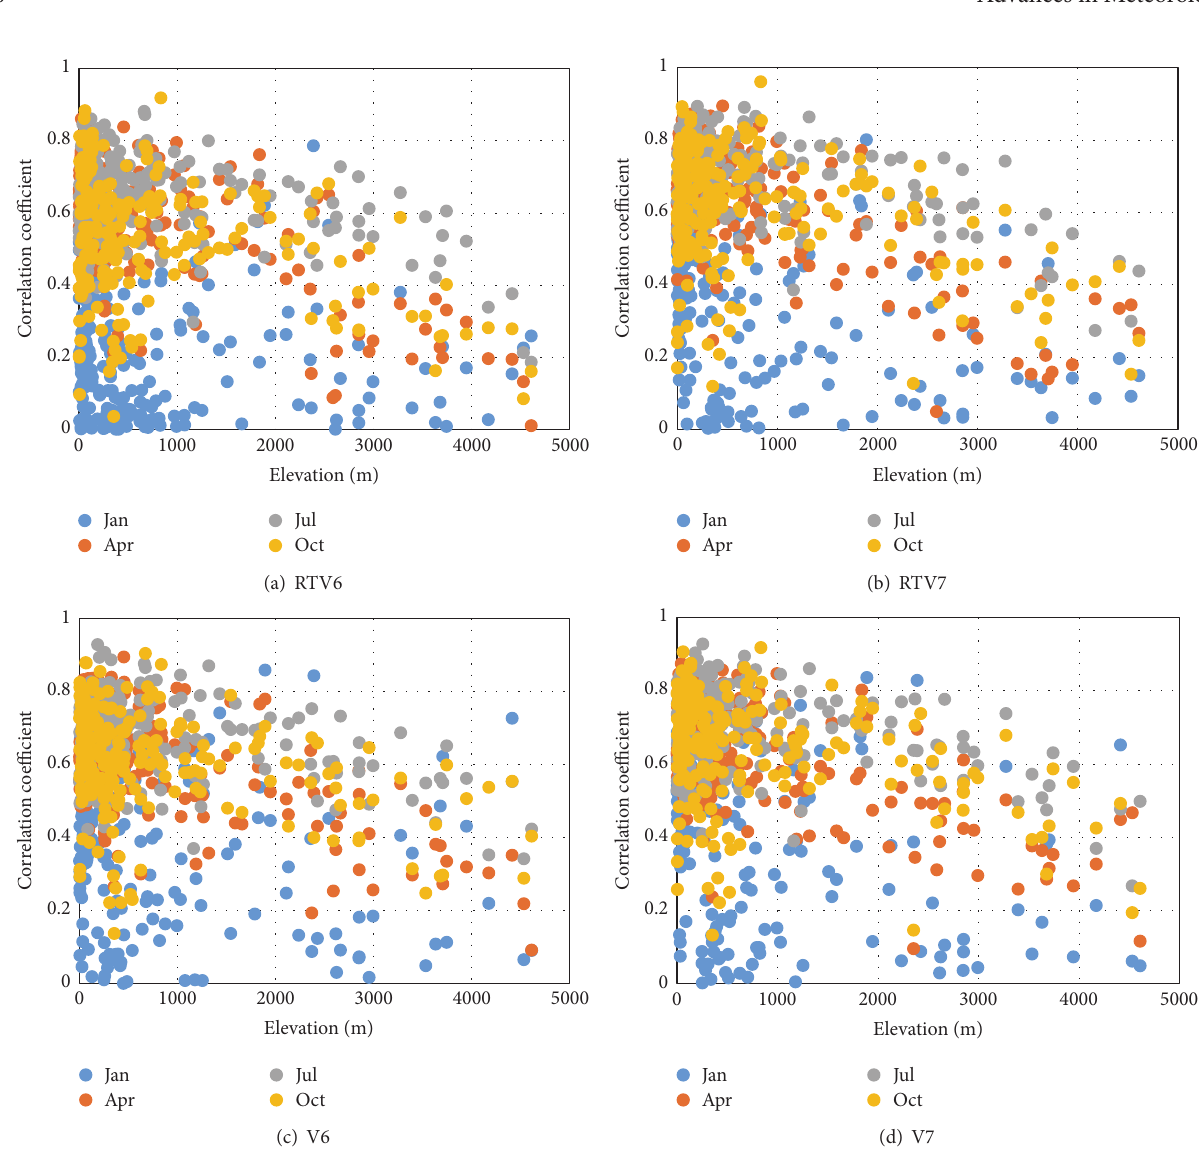
Figure 7: Seasonal distribution of correlation coefficient of TRMM precipitation and observed data with